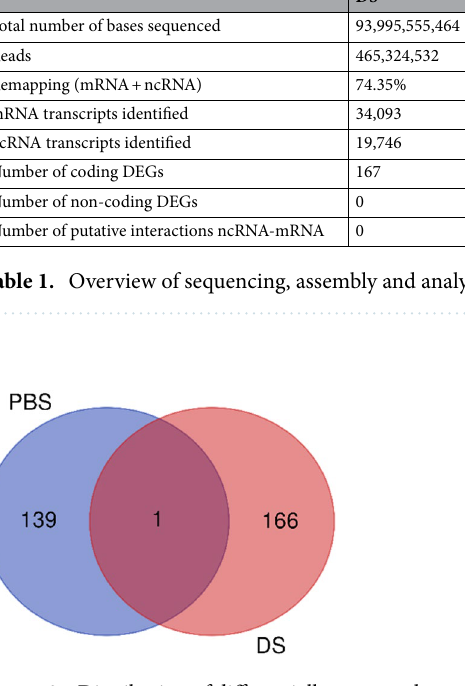
Figure 3. Distribution of differentially expressed genes between irradiated mice and their corresponding control group. Numbers corresponds to transcripts whose expression levels vary by more than a factor 2 and whose adjusted P value is less than